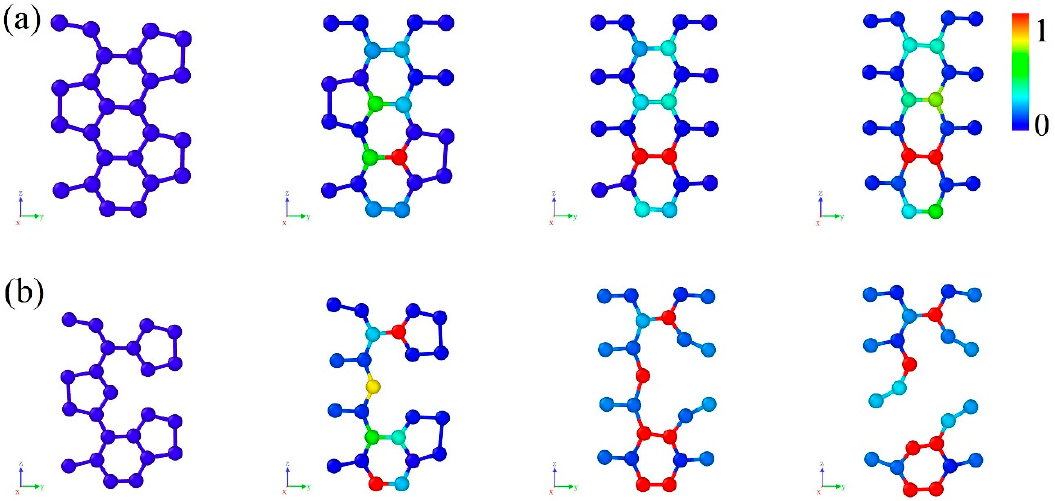
Figure 5. Evolution of local shear strain for loading along cell axis direction. ( a ) Pristine CHC. ( b ) CHC with defect 3.